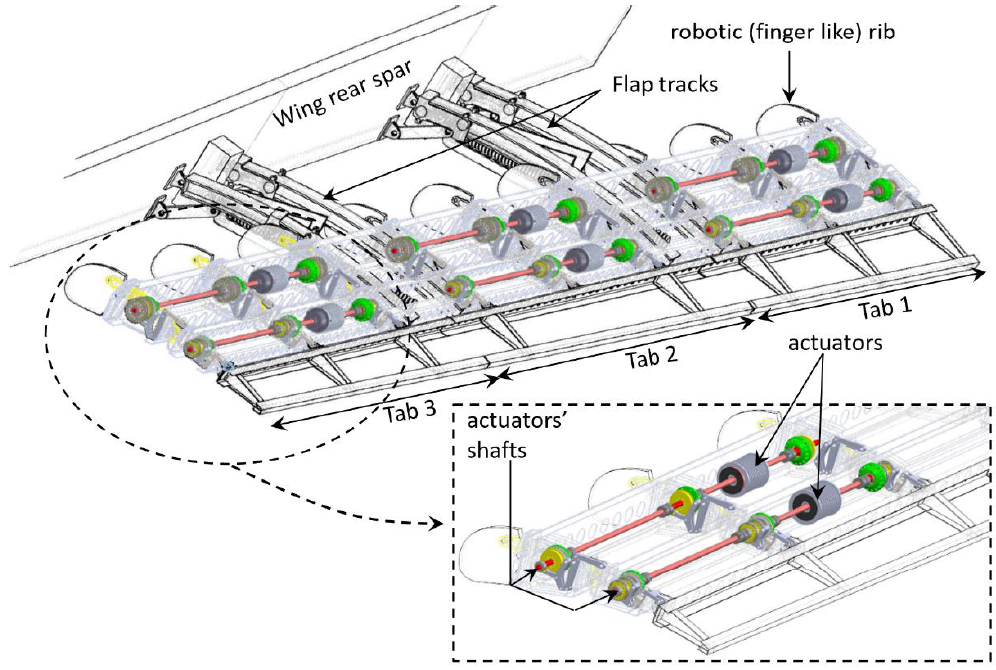
Figure 1. General layout of CleanSky2 Camber Morphing Flap. Each flap rib consists of four consecutive blocks (B0, B1, B2, and B3) hinged along the camber line at the positions marked by points A, B, and C in Figure 2. Block B0 and B2 are further connected through a link, denoted with L in Figure 2, which makes B0, B1, and B2 to move as a single degree-of-freedom mechanism. The last block, B3, is connected to block B2 only. Two rotary electromechanical actuators (A1, A2, in Figure 2) are adopted to morph the rib; the first actuator (A1) drives the motion of the first three blocks, while the second actuator (A2) controls the rotation of the last block around the hinge C. The torque of each actuator is duly amplified by optimized mechanisms (M1 and M2, in Figure 2) fully integrated in the robotic rib.